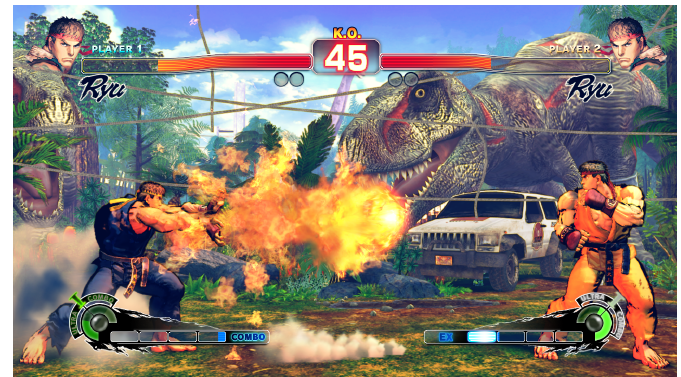
Figure 3. A snapshot of Street Fighter IV